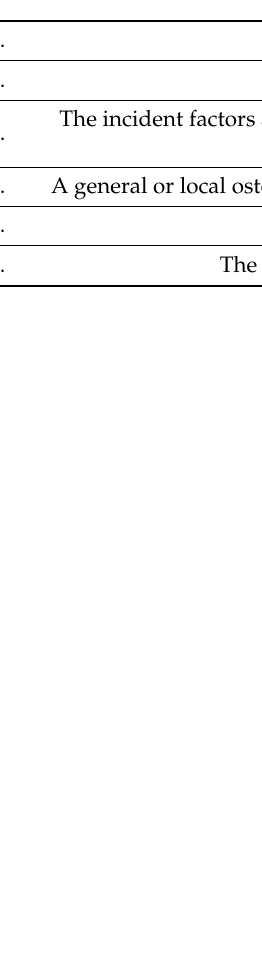
Table 1. The key points of this review are